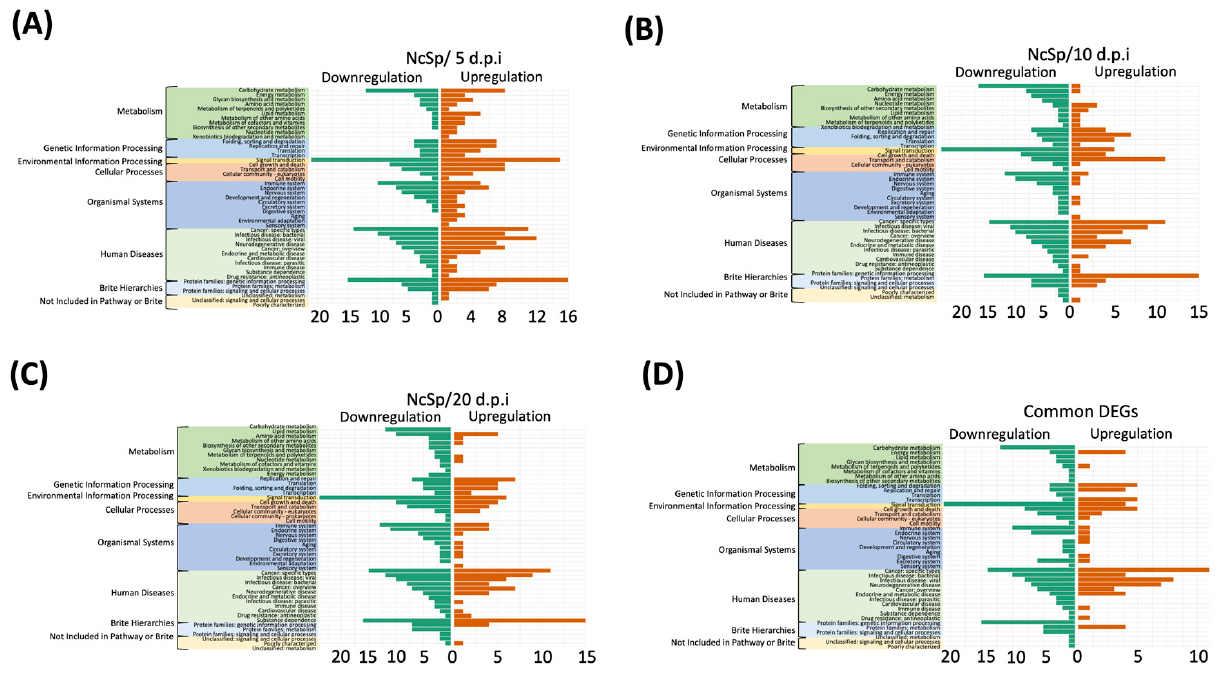
Figure 5. KEGG annotation of ( A – C ) DEGs and ( D ) common DEGs. The bar plots show the number of DEGs identified in the relative pathway based on the KEGG pathway